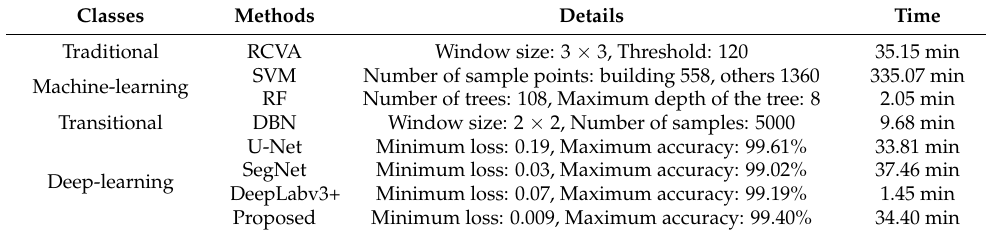
Table 5. Details of experiment